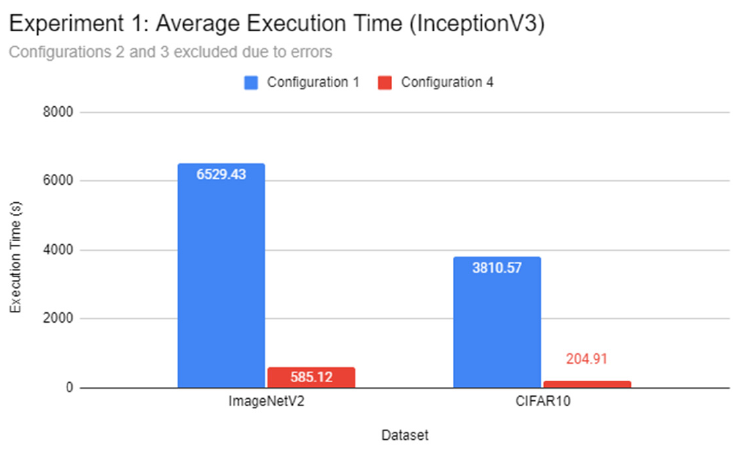
Figure 6. Average execution time results using InceptionV3 in Experiment 1.